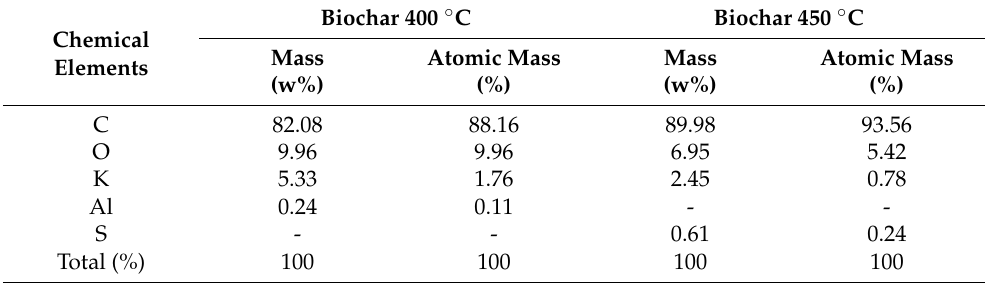
Table 3. EDX analysis of biochar in nature.